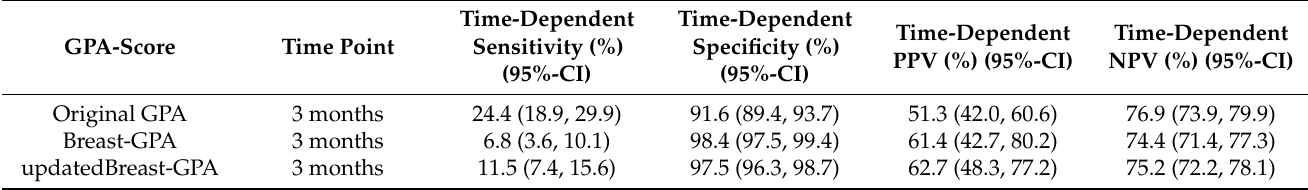
Table 6. Diagnostic accuracy of the original GPA, the Breast-GPA and updated Breast-GPA score at the time of 3 months for a cut off value of 1, comparing the lowest category versus the three higher categories of each score.